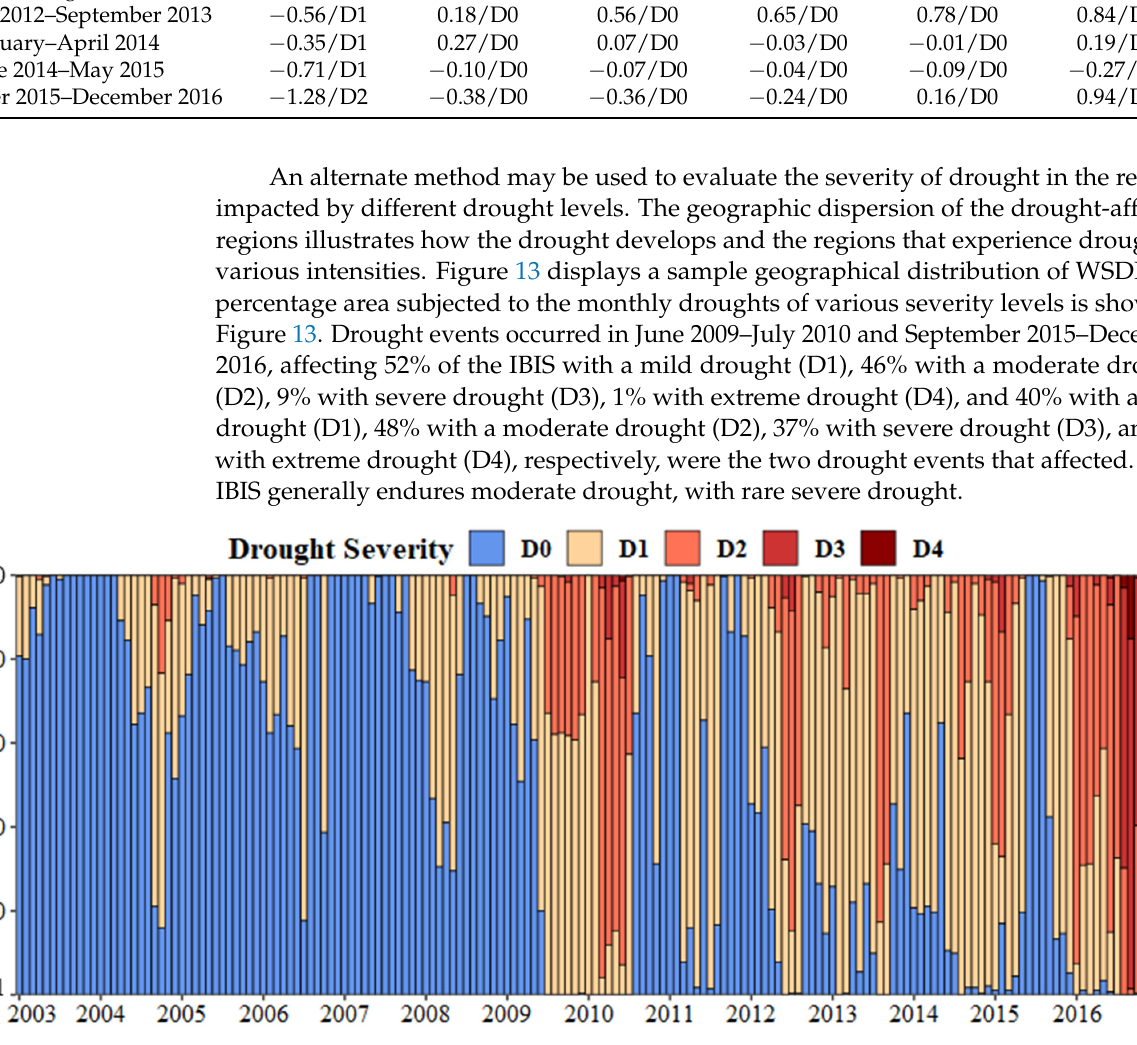
Figure 13. The percentage of the area subjected to droughts of varying severity from 2003 to 2016 (D0: no drought; D1: mild drought; D2: moderate drought; D3: severe drought; D4: extreme drought).